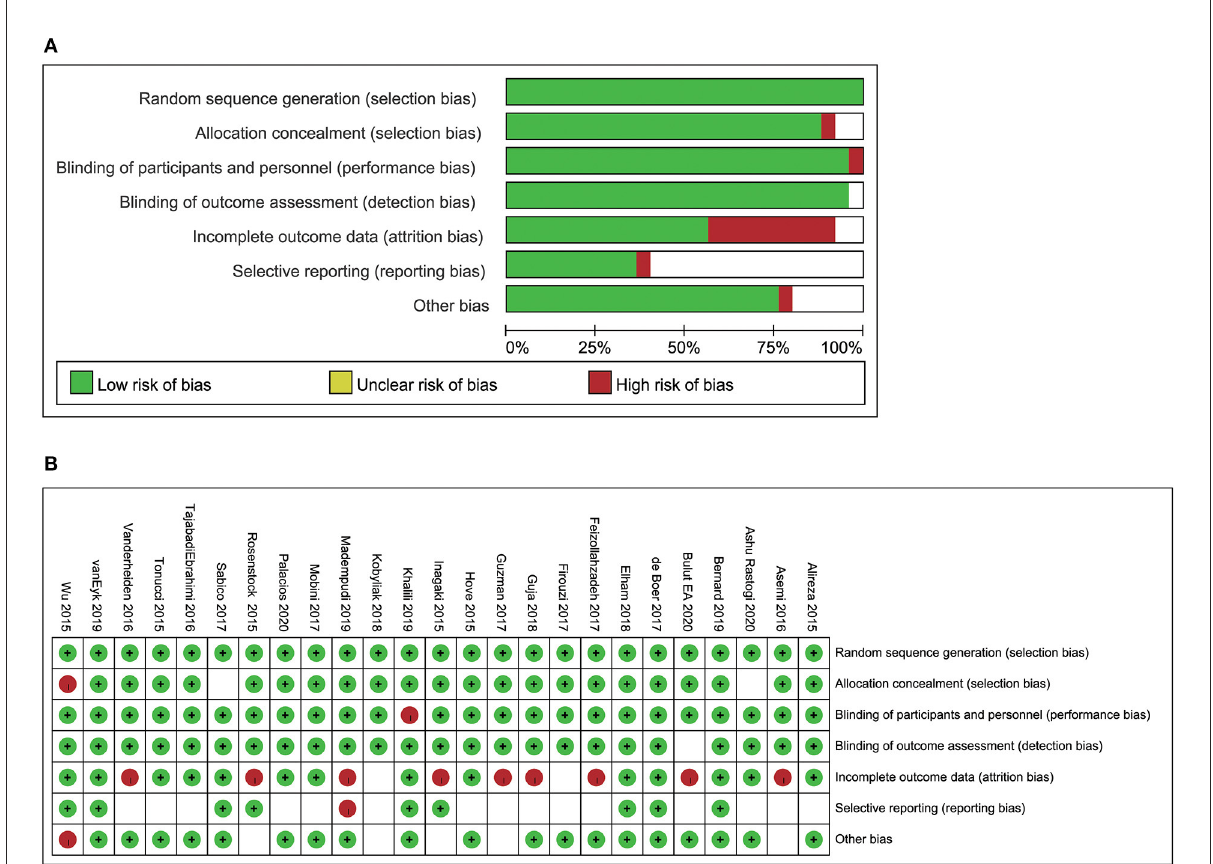
FIGURE2 Risk of bias analysis (A) the analysis of the individual studies included in the systermatic review and meta-analysis. (B) The summary of the risk of bias analysis.